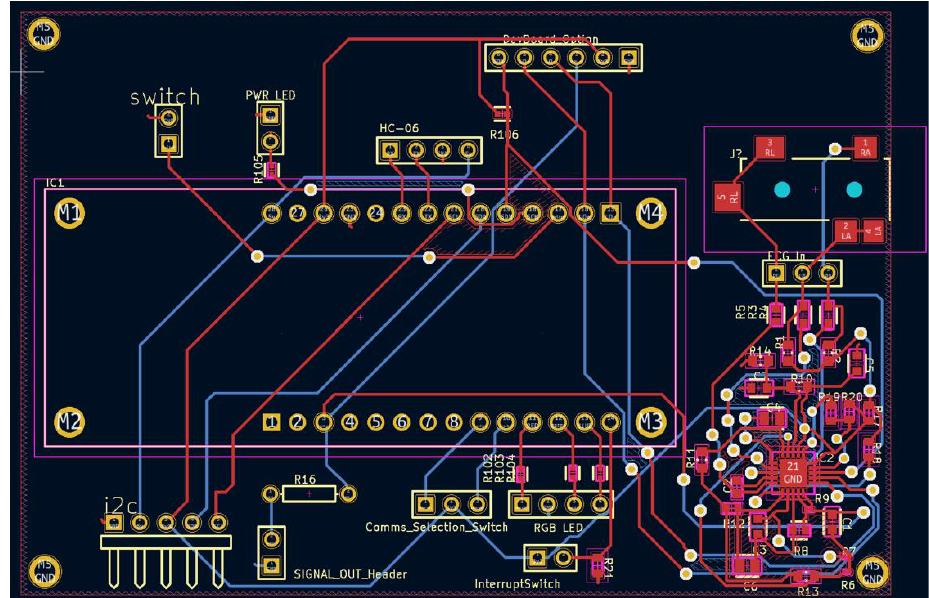
Figure 4. PCB layout highlight the routing and placement of various components.